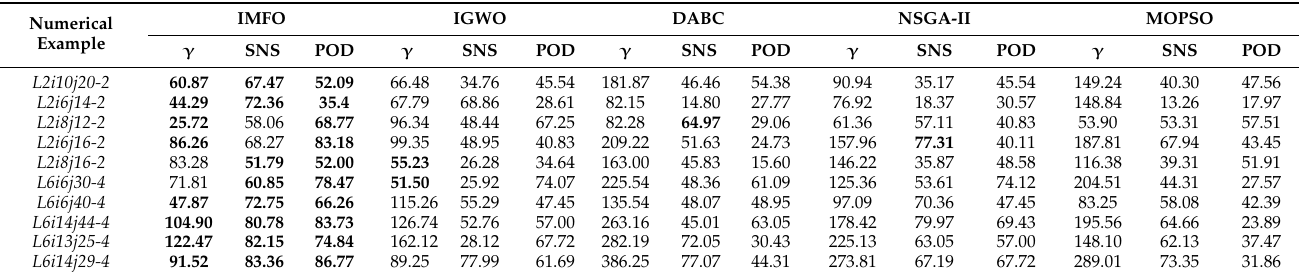
Table 2. Comparison of the results for examples of different scales.